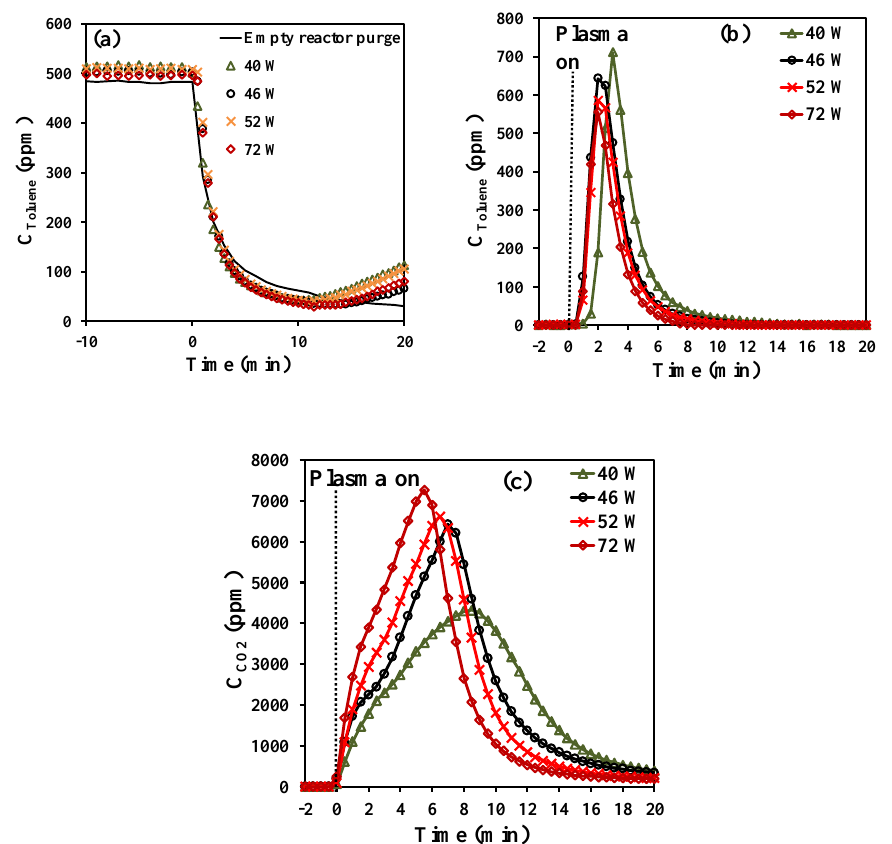
Figure 3. Effect of NTP power on the concentration profiles of ( a ) toluene during the adsorption step (including a blank test without catalyst), ( b ) toluene during NTP exposure for the first 20 min (toluene desorption), and ( c ) CO 2 during NTP exposure for the first 20 min (CO 2 formation).